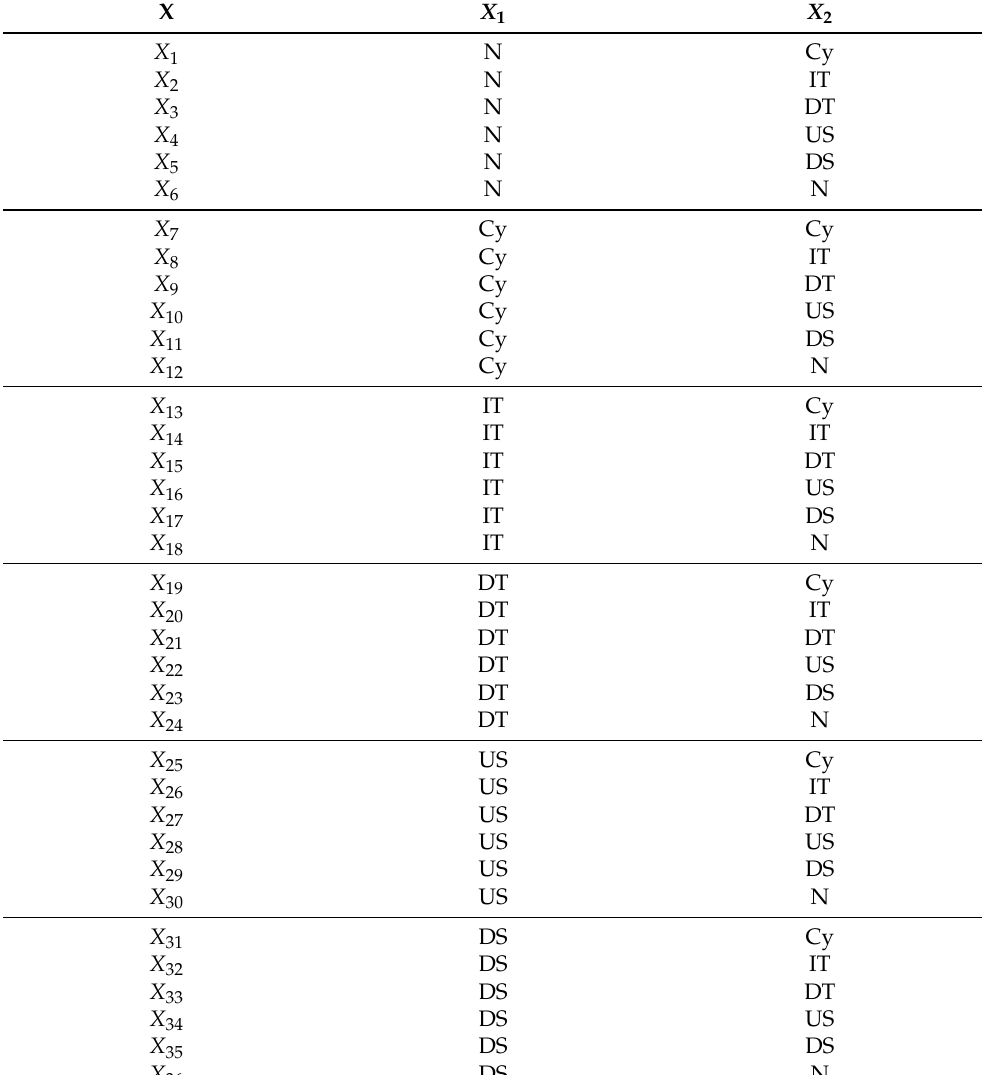
Table 1. Types of multivariate variables generated with 2 variables in X = [ X 1 , X 2 ] . Increasing Trend (IT), Decreasing Trend (DT), Downward Shift (DS), Upward Shift (US), Cycle (Cy) and Normal